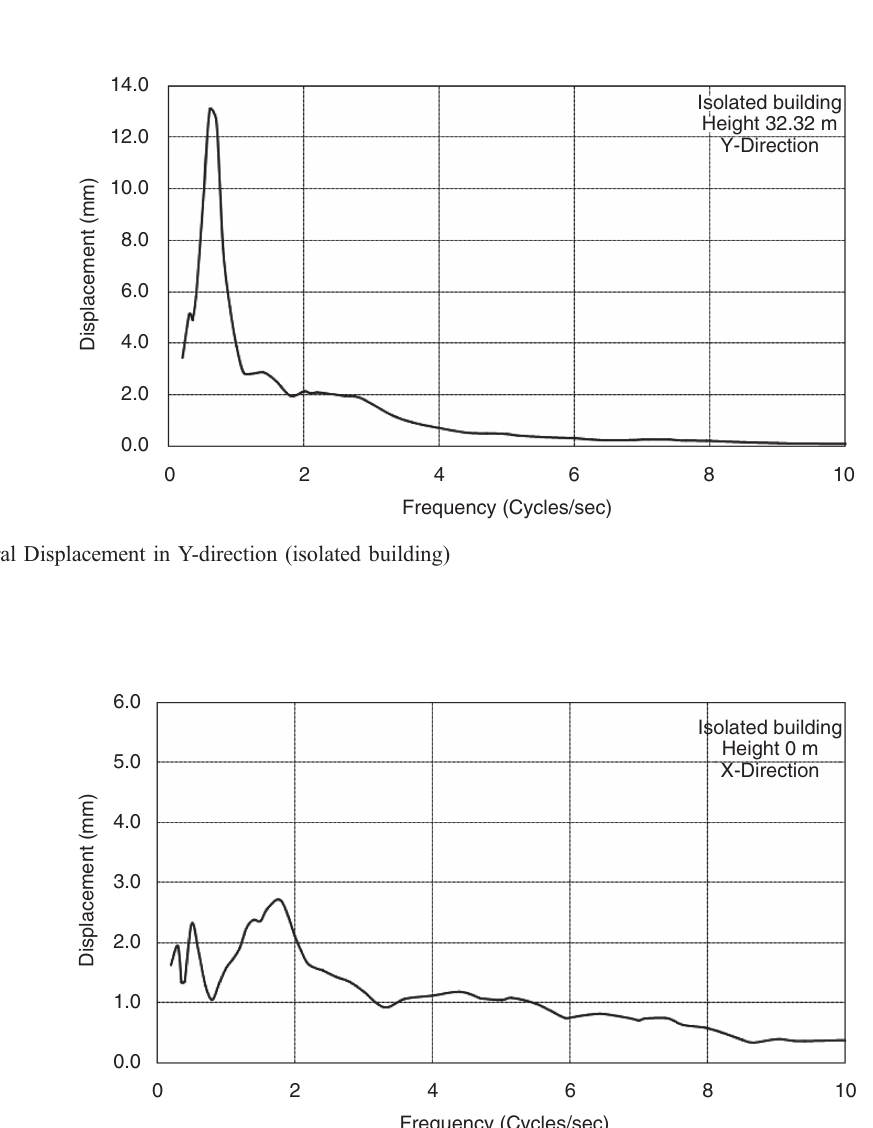
Fig. 18. Spectral Displacement in X-direction (isolated